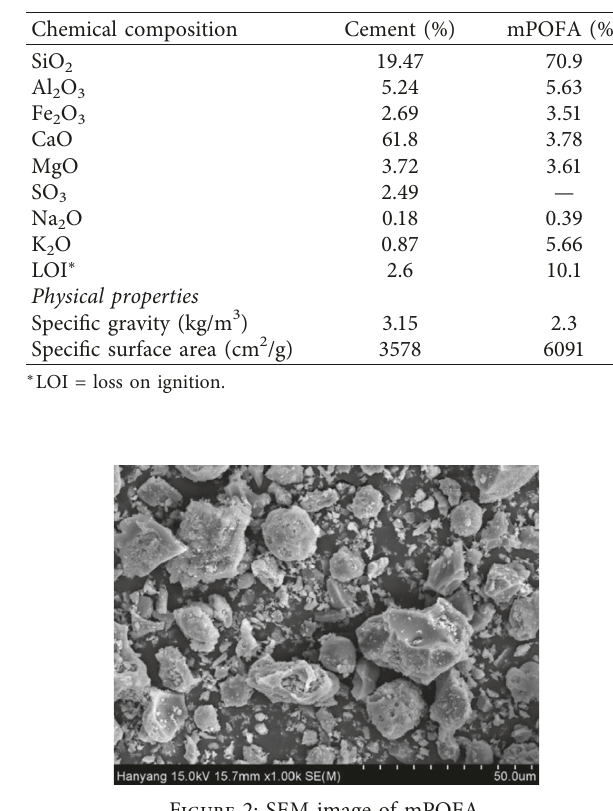
Figure 1: Production of palm oil fuel ash (POFA). Table 1: Physical properties and chemical composition of cement and mPOFA.